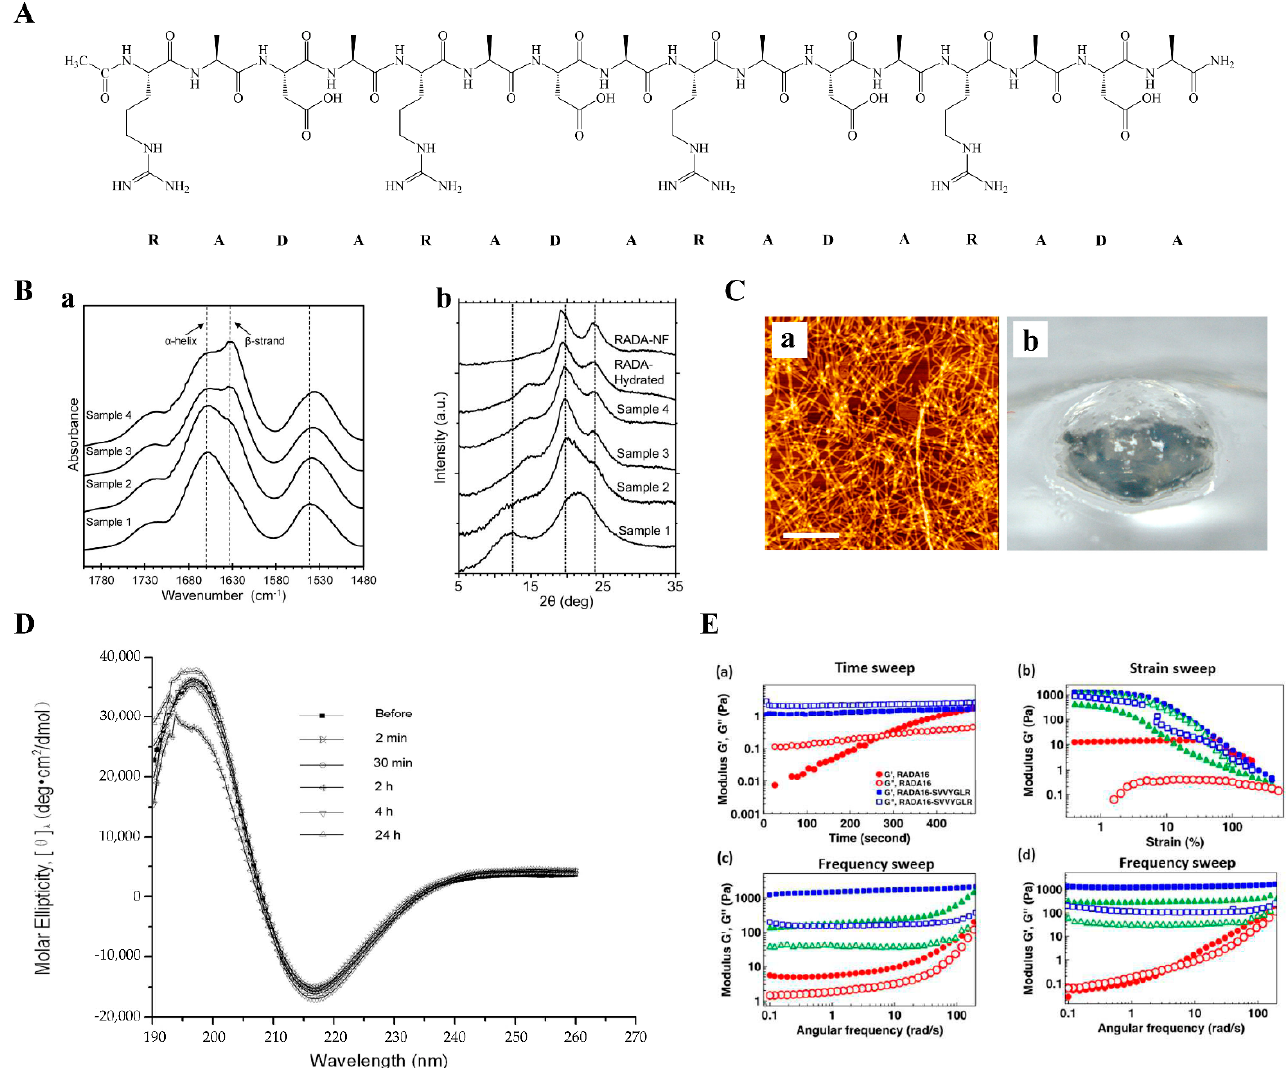
Figure 1. The general properties of RADA16-I. ( A ) Chemical structures of RADA16-I. ( B ) FTIR spectra for RADA16-I at different temperatures ( a ). WAXD diffractograms for Samples 1–4, RADA-Hydrated, and RADA-NF ( b ). The temperatures from Samples 1–4 are 298 K, 344 K, 347 K, and 363 K, respectively. ‘RADA-Hydrated’ refers to Sample 1, hydrated by adding 1 mg H 2 O/1 mg of the peptide. ‘RADA-NF’ refers to the sample that has been self-assembled in the aqueous salt solution. Adapted with permission from Ref. [31]. Copyright 2013 Journal of Peptide Science. ( C ) Atomic force microscope (AFM) image ( a ) and macroscopic image ( b ) of RADA16. ( D ) CD examination of the peptide structures at various times before and after sonication: 2 min, 30 min, 2 h, 4 h, and 24 h. Adapted with permission from Ref. [32]. Copyright 2012 International Journal of Molecular Sciences. ( E ) Rheological behavior of RADA16-I and RADA16-SVVYGLR (a functionalized sequence of RADA16) . ( a ) Time sweeps of 1% ( w / v ) RADA16-I and RADA16-SVVYGLR. ( b ) Strain sweeps of 1% ( w / v ) RADA16 and RADA16-SVVYGLR in various pH conditions. ● : RADA16-I in pH3; ▲ : RADA16-I in pH7; ◼ : RADA16-I in pH13; ○ : RADA16-SVVYGLR in pH3; △ : RADA16-SVVYGLR in pH7; □ : RADA16-SVVYGLR in pH13. Frequency sweep of 1% ( w / v ) RADA16-I ( c ) and RADA16-SVVYGLR ( d ) in various pH conditions. Symbols for storage modulus (G’): ● : pH3; ▲ : pH7; ◼ : pH13; for loss modulus (G”): ○ : pH3; △ : pH7; □ : pH13. ( n = 3). Adapted with permission from Ref. [33]. Copyright 2017 Nanoscale.